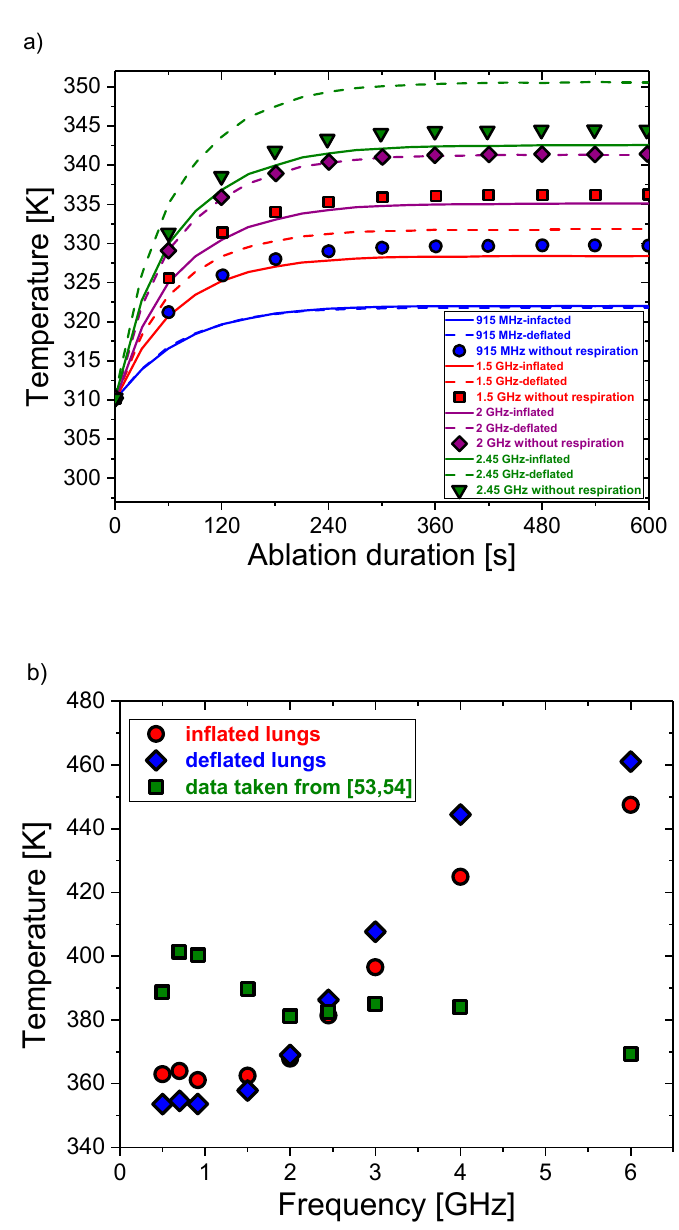
Figure 6. ( a ) Temporal evolution of the temperature. The results of calculations using permittivity and conductivity corresponding to inflation, deflation, and regardless of respiration are shown by solid curves, dash curves, and symbols, respectively. ( b ) The dependence of the maximum temperature on the frequency. Figure 7 contains a numerical prediction of the fraction of necrotic tissue after 600 s of exposure to frequencies between 915 MHz and 2.45 GHz. Whether the lungs are in- flated (Figure 7a) or deflated (Figure 7b), or respiration is not taken into account (Figure 7c), the damage zones are concentrated around the tip and slot of the antenna, while the backward heating effect is smaller. The extension of the necrotic tissue increases with the